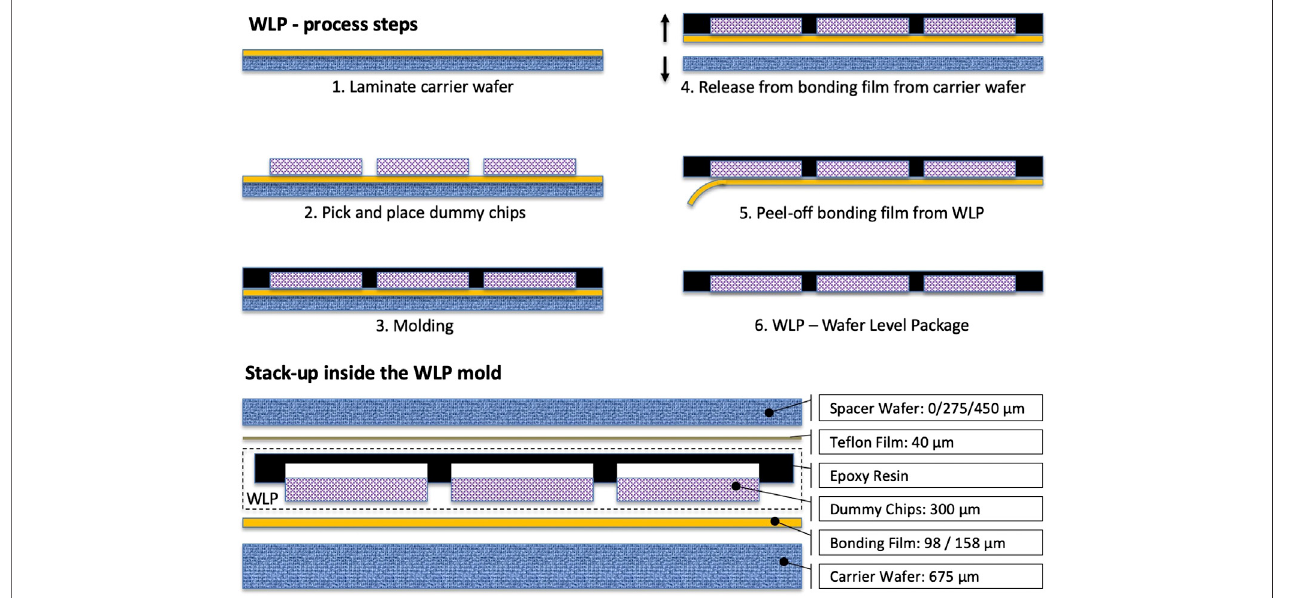
FIGURE 2 | Top: the six steps of WLP process fl ow. Bottom: the complete stack-up present in the mold.